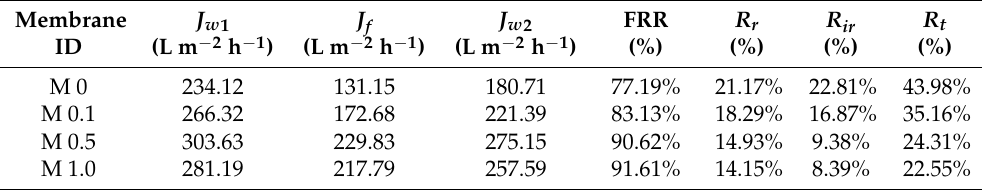
Table 1. Antifouling performance of the pristine and Ag-CuO NP-coated membranes.